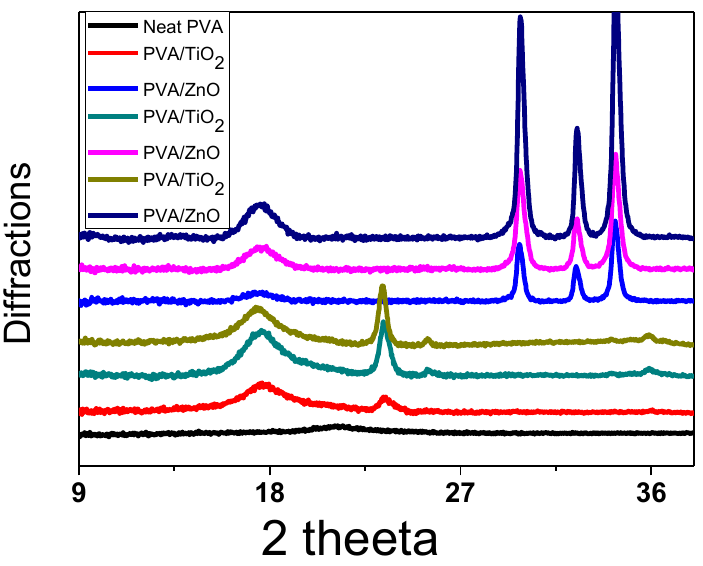
Figure 6. X-ray diffraction (XRD) spectra of Neat PVA nanofibers and PVA/ZnO nanofibers.